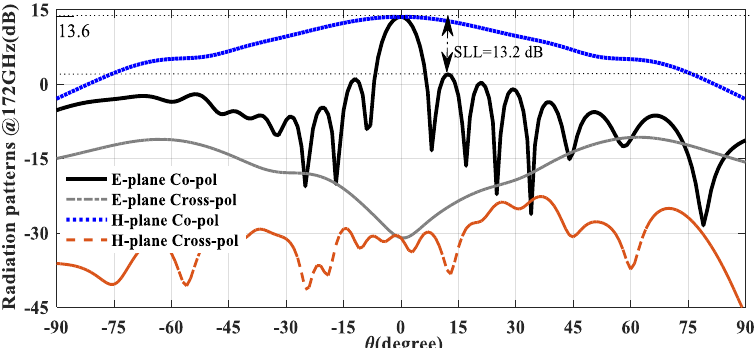
Figure 5. Simulated co- and cross-polar E-plane and H-plane radiation patterns at the broadside frequency of 172 GHz.